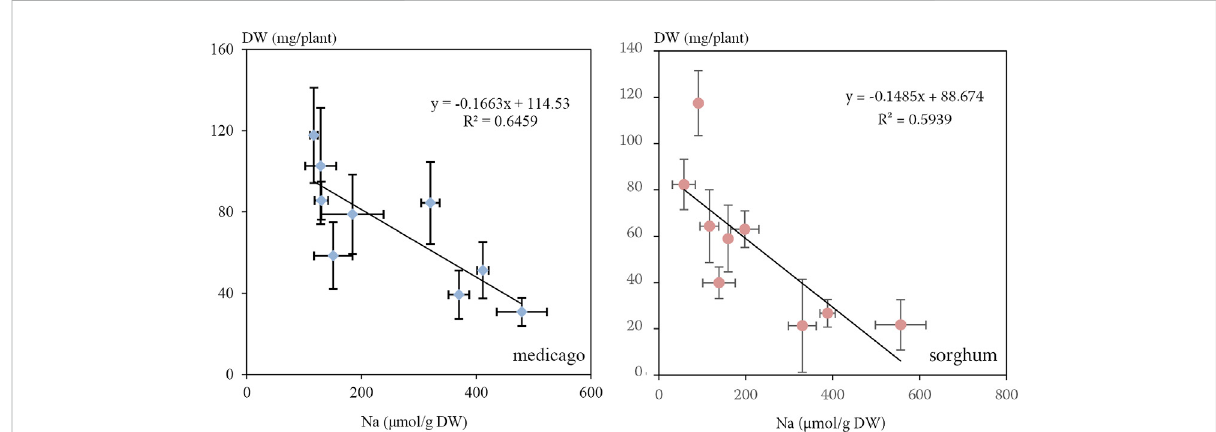
FIGURE 3 Relationship between sodium uptake and dry weight yield of alfalfa and sorghum